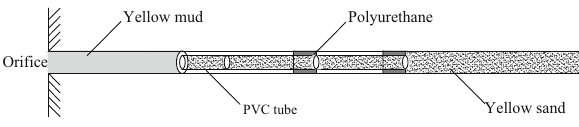
Fig. 4 Sealing structure of cumulative blasting (Shang et al.